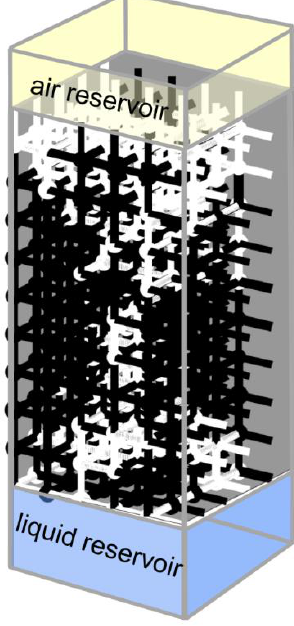
Figure 2. Schematic of the pore network used for capillarity-controlled invasion percolation (IP) simulations. The pore network is connected to air reservoir at the top and liquid reservoir at the bottom. Throats/pores filled with liquid are shown in black, whereas gas throats/pores are shown in white.